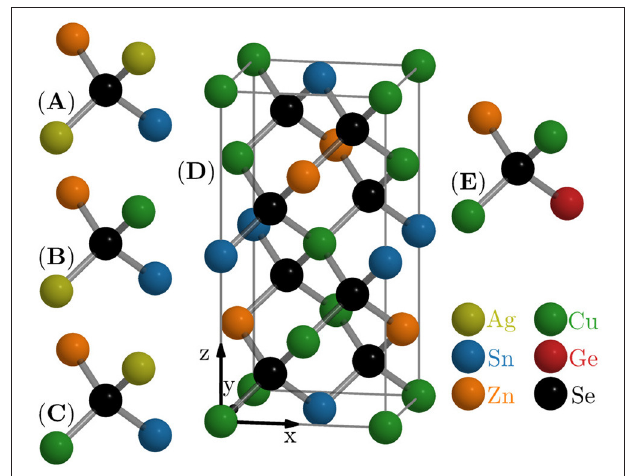
FIGURE 1 | Unit cell of the kesterite-type Cu 2 ZnSnSe 4 (D) and local tetrahedra for (Ag,Cu) 2 ZnSnSe 4 (A–C) and Cu 2 ZnGeSe 4 (E) .